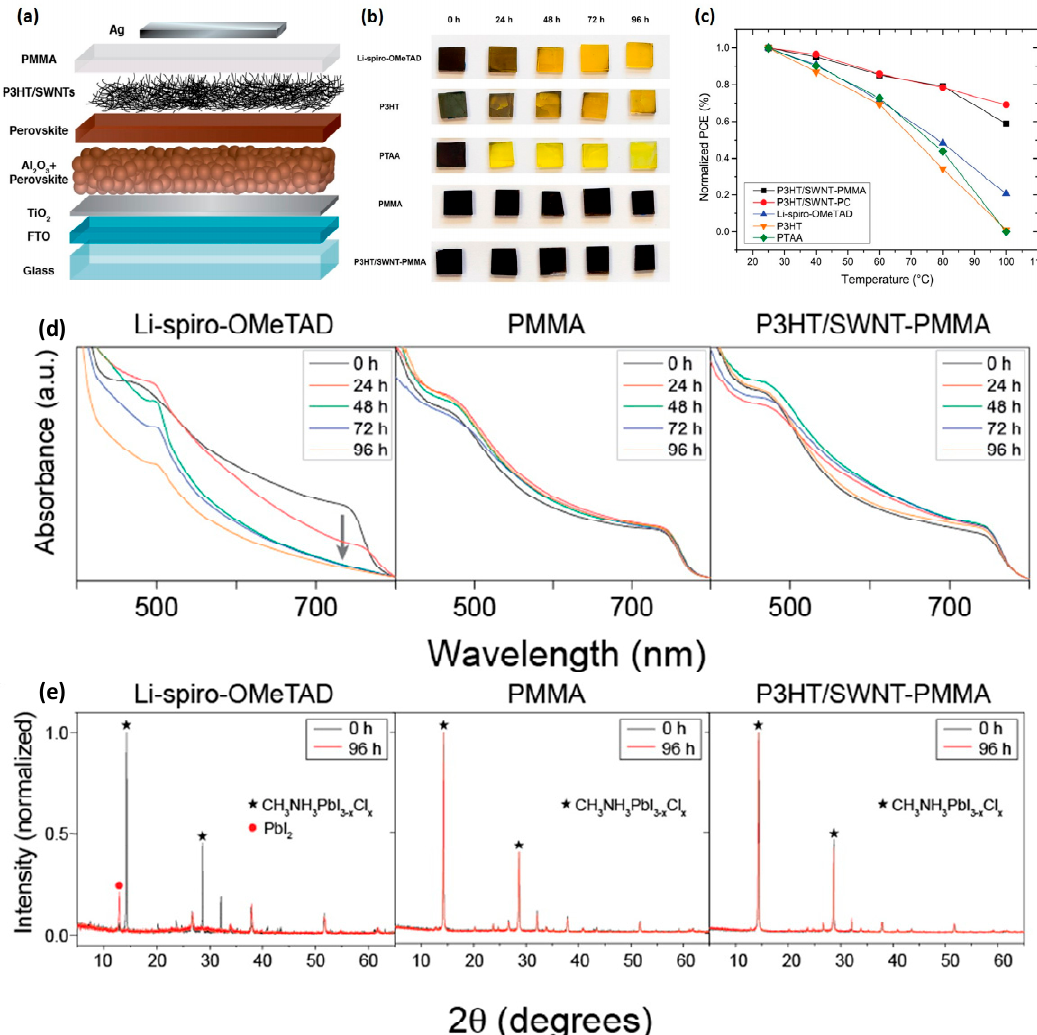
Figure 9. ( a ) Schematic of a solar cell where carbon nanotube/polymer composite is used as a hole-transport layer. ( b ) Photographs illustrating the visible degradation of the perovskite layer for various HTLs. ( c ) Temperature dependent power conversion efficiency for perovskite solar cells as a function of temperature for different HTLs. ( d ) Absorption measurements and ( e ) XRD patterns of sample with different HTLs before and after annealing for 96 h. Reprinted with permission from [64]. Copyright (2014) American Chemical Society. PMMA: poly (methyl methacrylate); SWNT: single-walled nanotubes.